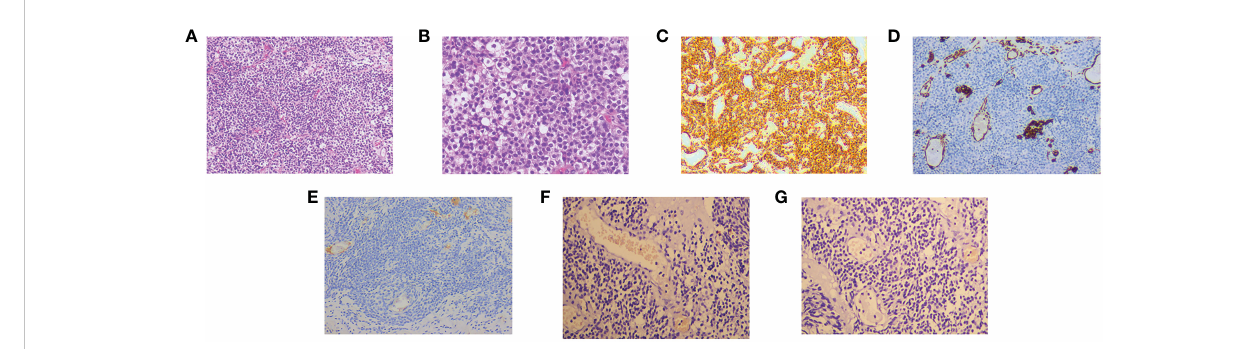
FIGURE 2 The hematoxylin – eosin (HE) and immunohistochemical pictures. (A) The tumor cells are uniform in size, round in shape, well-de fi ned, and distributed around blood vessels (HE, original magni fi cation, 100×). (B) The tumor cells show diffuse heterogeneous proliferation, increased mitotic signs, and visible multifocal necrosis (HE, original magni fi cation, 200×). Immunohistochemistry: SMA (C) , Vimentin (D) , Desmin (E) , TFE3 (F) , and HMB45 (G)